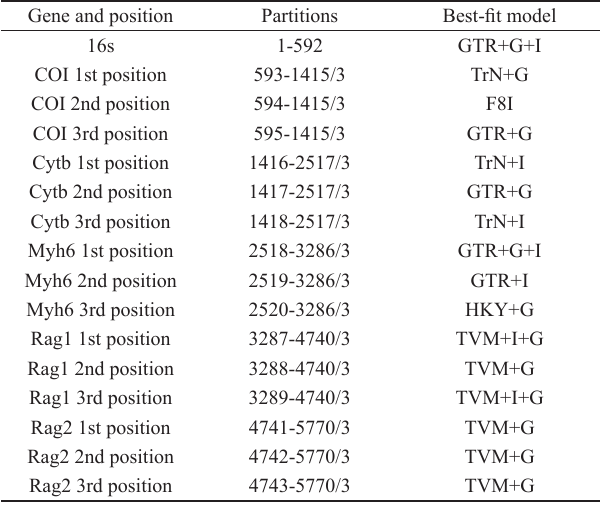
Tab. 2. Gene partitions and their models as selected by